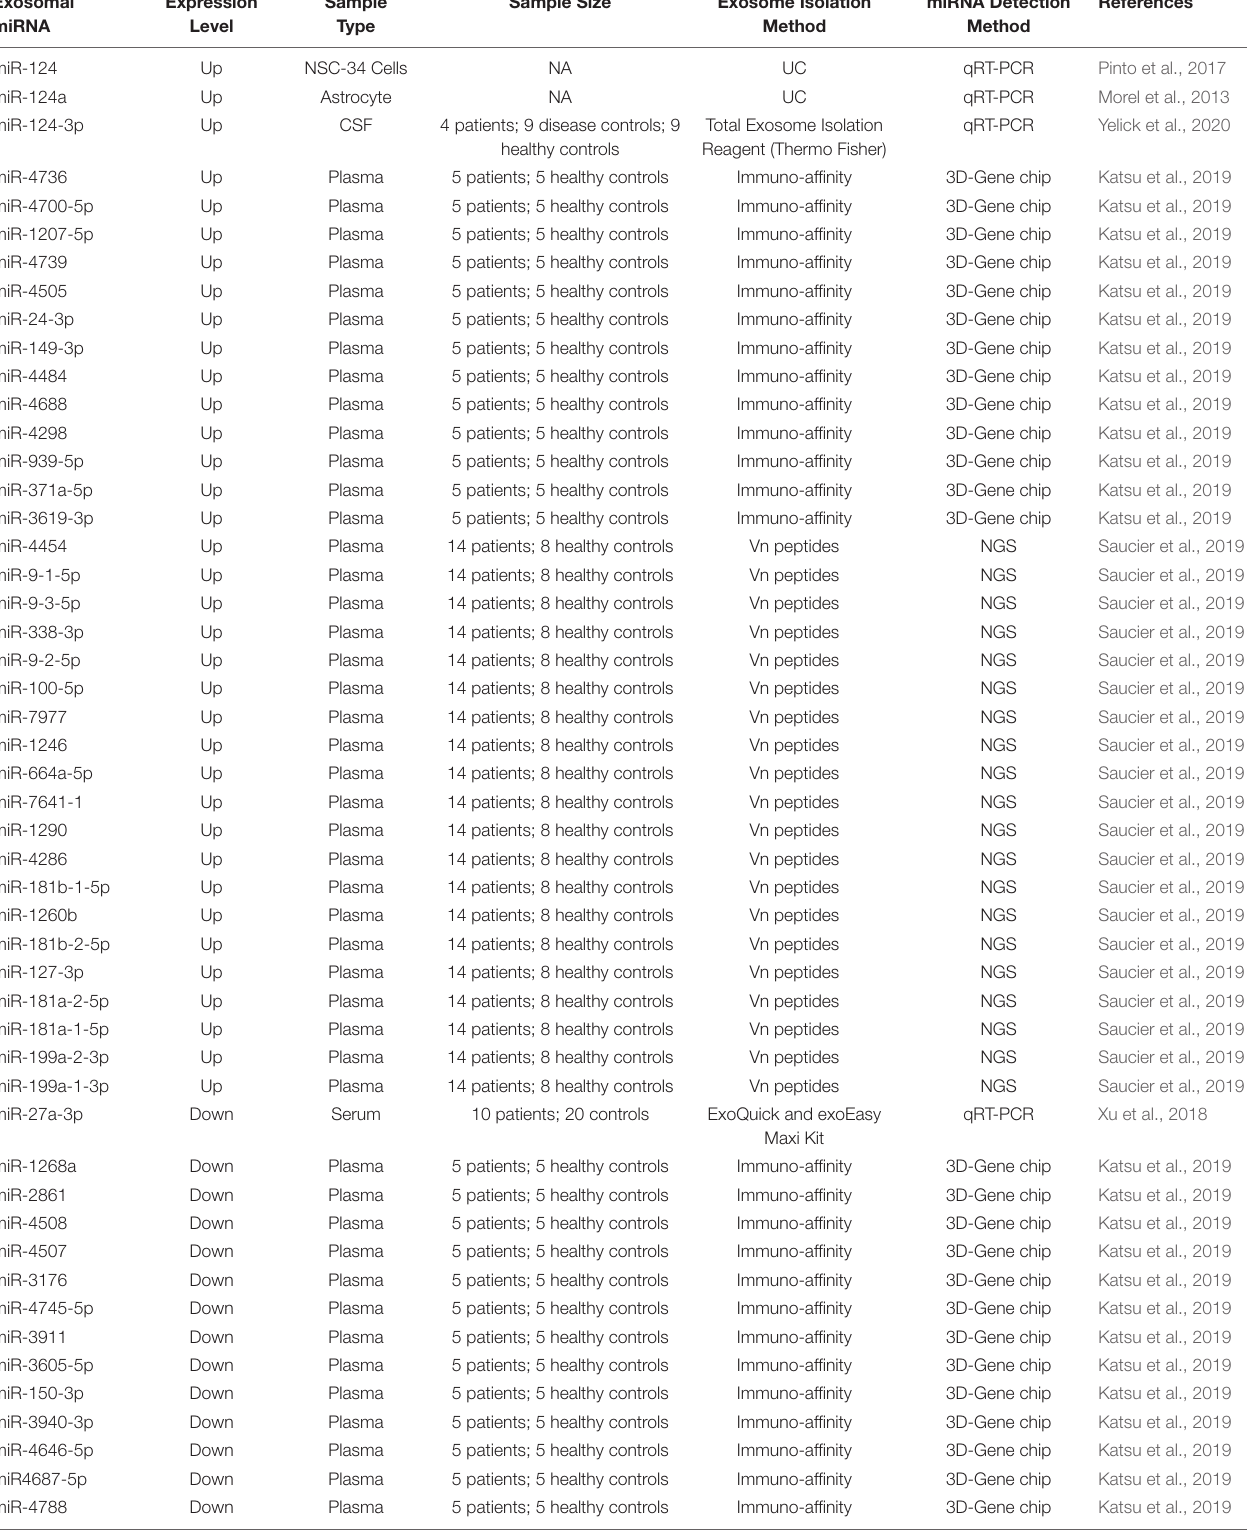
TABLE 1 | Differentially expressed exosomal miRNAs in ALS. Exosomal